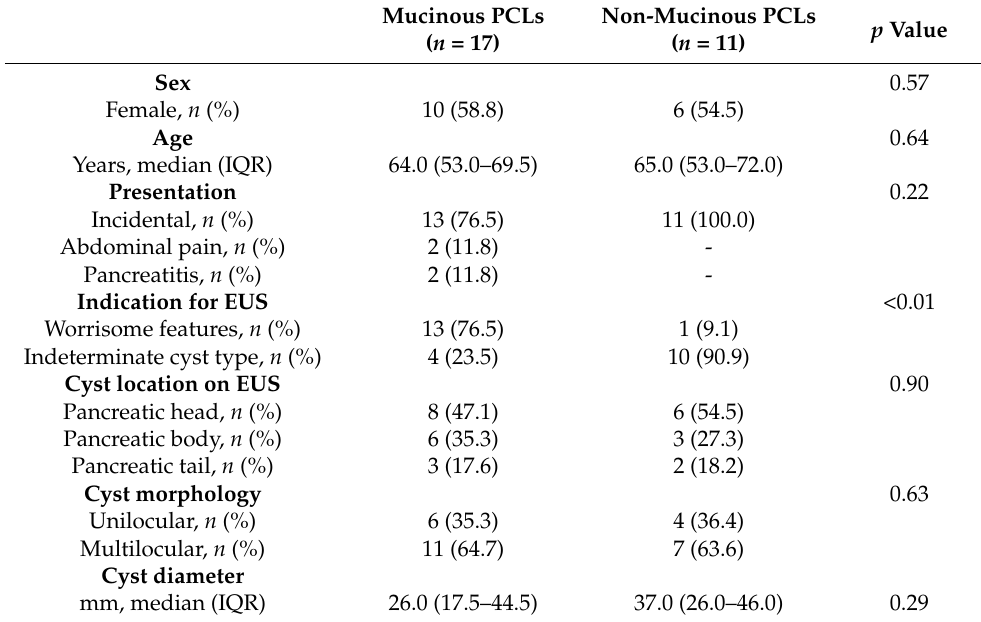
Table 1. Baseline clinical and demographic